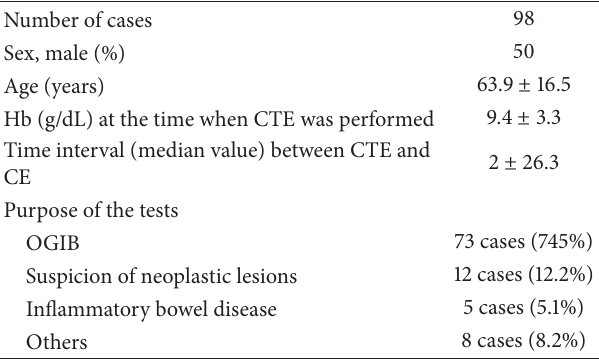
Table 1: Characteristics of the patients participating in the